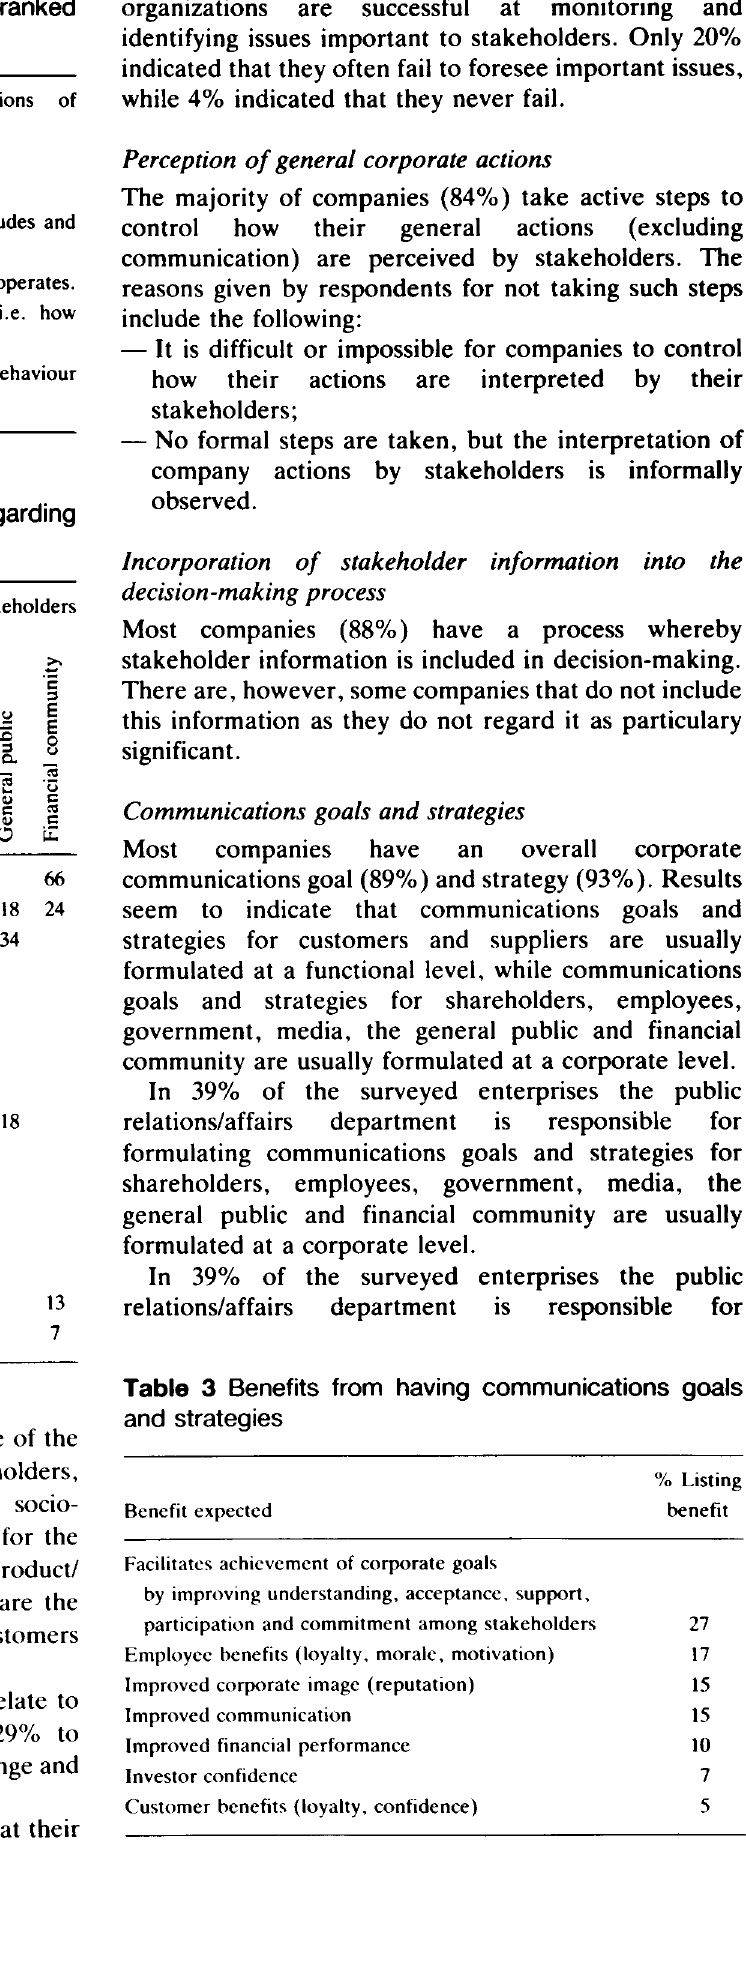
Table 2 Percentage of business enterprises regarding various issues as important to